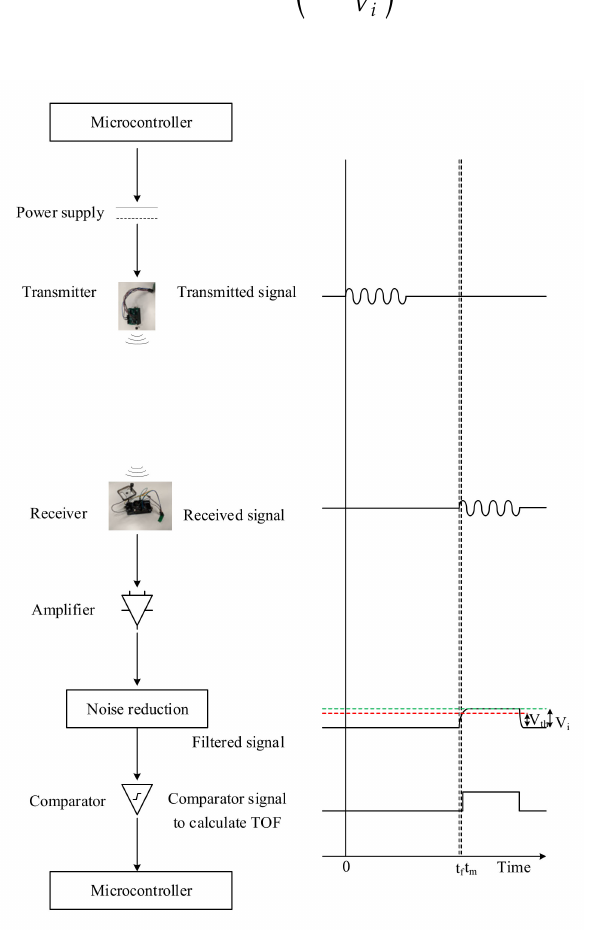
Figure 4. Acoustic positioning and navigation system (adapted from